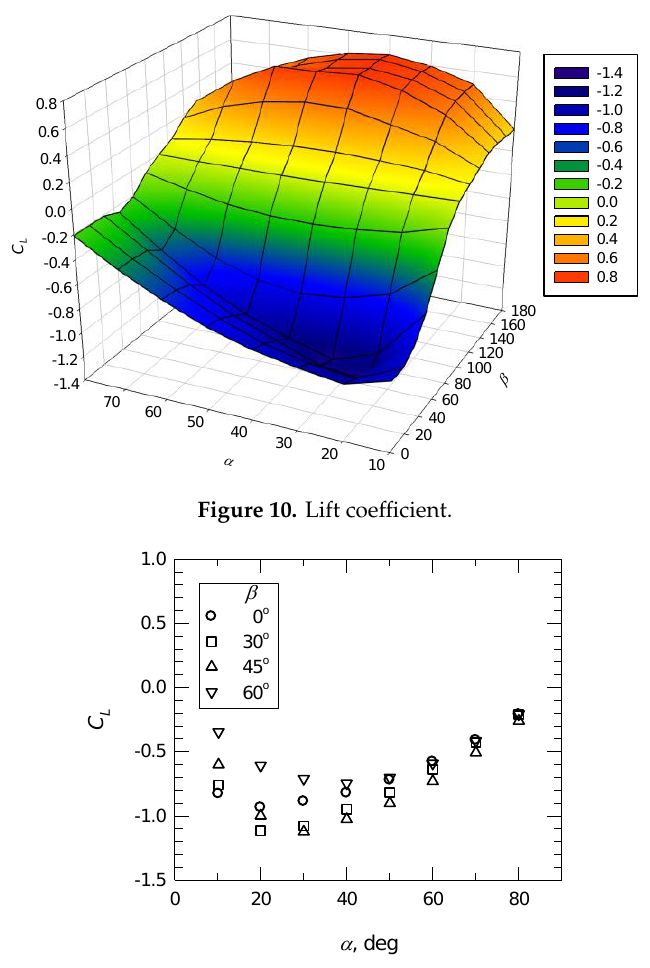
Figure 11. Lift coe ffi cient. β : 0 ◦ , 30 ◦ , 45 ◦ , 60 ◦ Figure 11. Lift coefficient. β : 0°, 30°, 45°, 60°. Figure 11. Lift coefficient. β : 0°, 30°, 45°, 60°.